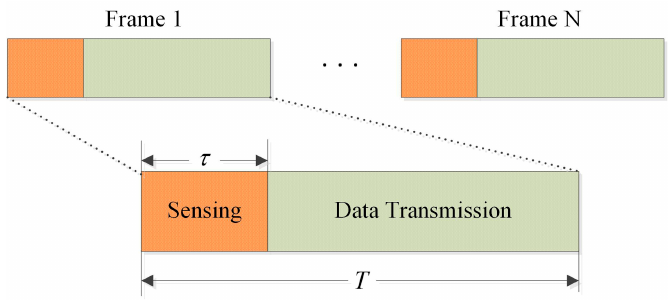
Figure 3. Frame structure of periodic spectrum sensing.